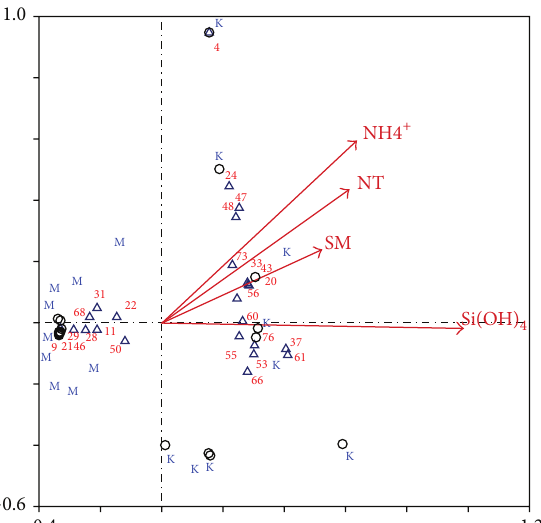
1.0 Figure 4: Diagram of canonical correspondence analysis (CCA) showing the effects of nutrient ratios on microalgae species ordi- nation according to the first and second axes. Species associated with K (disturbed station) were the dinoflagellates 3: Amphidinium carterae , 19: Karlodinium veneficum , 8: Ceratium candelabrum , 6: Ceratium fusus , 38: Protoperidinium diabolum , 34: Protoperidinium divergens , 20: Karenia selliformis , and 41: Pyrophacus sp., the diatoms 51: Climacosphenia sp., 47: Biddulphia sp., 54: Licmophora sp., 49: Coscinodiscus sp., 50: Chaetoceros sp., and 45: Amphora sp., and the cyanobacteria 71: Thalassiosira sp. Species associated with M (control station) were the dinoflagellates 9: Coolia monotis , 11: Diplopsalopsis sp., 21: Ostreopsis ovata, 22: Peridinium sp., 28: Pro- rocentrum lima , 31: Protoperidinium sp., 29: Prorocentrum triestinum and the diatoms 45: Asterionellopsis glacialis , 58: Navicula sp. Species whose coverage and frequency were less than 40% were